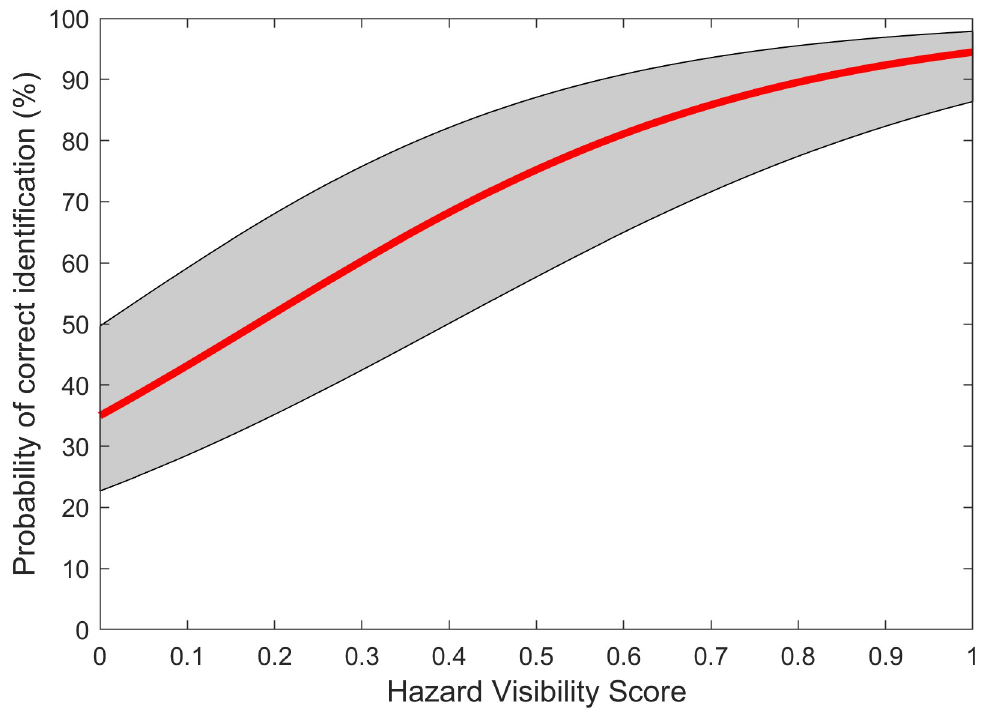
Fig 7. Logistic regression model of aggregated data from low-vision subjects. The red line shows the regression curve and the gray area outlines the upper and lower bounds of the 95% confidence interval of the slope and intercept. (less severe) vision loss. Fig 9 shows the scatterplots of logistic regression slope values plotted against acuity and contrast sensitivity. Regression lines are also presented.